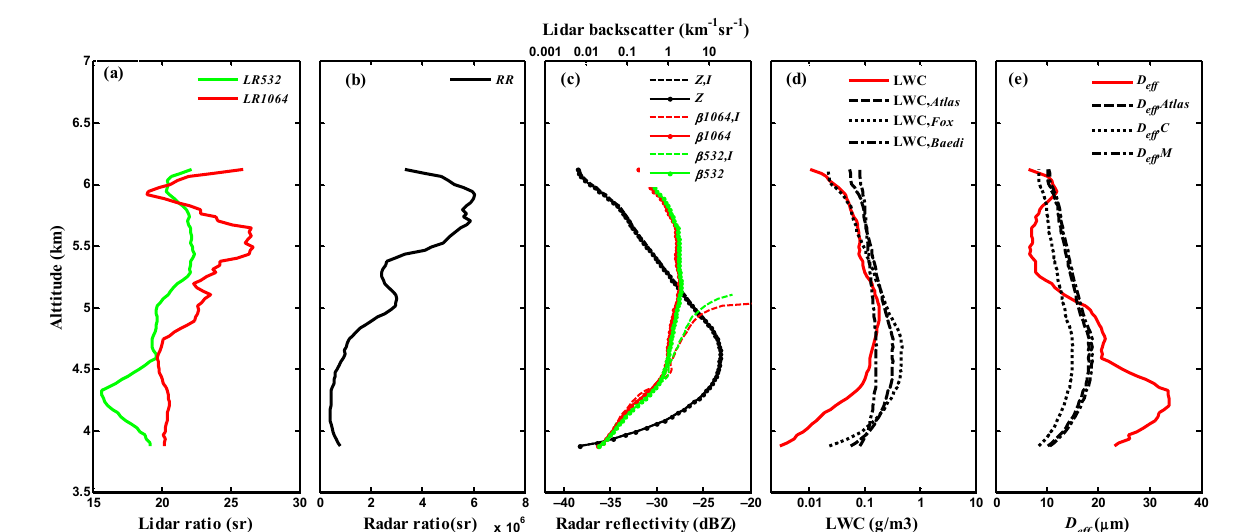
Figure 9. Time–height profile of Z ( a ) and 1064 nm ranged corrected signal (RCS) ( b ) on 10 October 2019.